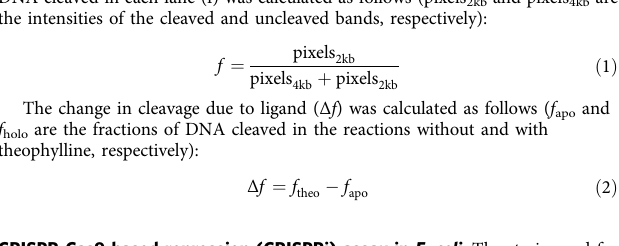
water, then 200 mL pre-chilled water, then 200 mL pre-chilled 10% glycerol; resuspend in a total volume of 6 mL pre-chilled 10% glycerol; make 100 μ L aliquots; fl ash-freeze and store at − 80 °C. Electrocompetent cells were transformed as follows: thaw competent cells on ice for 10 min; pipet once to mix cells with 2 μ L ≈ 250 ng/ μ L library plasmid; shock at 1.8 kV with a 5 ms decay time; immediately add 1 mL pre-warmed SOB with catabolite repression (SOC) medium; recover at 37 °C for 1h; dilute into selective liquid media and grow at 37 °C with shaking at 225 rpm overnight. After PCR and ligation, libraries were transformed into electrocompetent Top10 cells, mira-prepped 47 , sequenced, combined to achieve approximately equal representation of variants based on library size and DNA concentration, and transformed into electrocompetent MG1655 cells already harboring the dCas9 plasmid. Cells were grown as for the CRISPRi assay, but when starting new cultures, care was taken to subculture at least 10× more cells than the size of the library